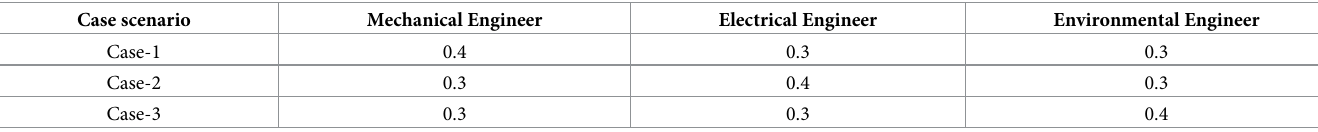
Table 6. Assigned weights based on the educational background of the experts. Case